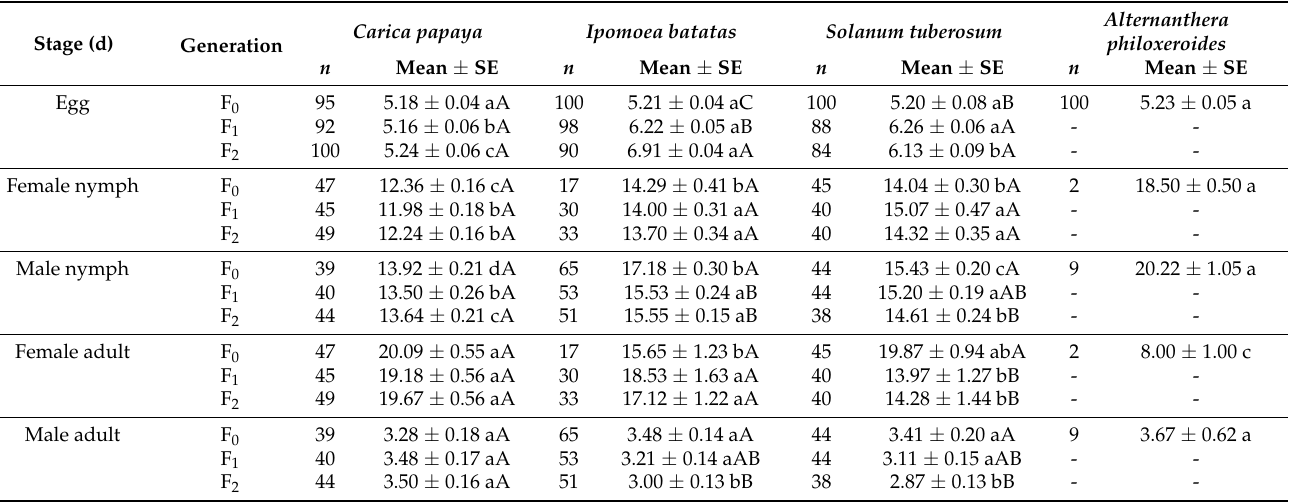
Table 1. The developmental times of Paracoccus marginatus individuals reared on four different host plants (F 0 –F 2